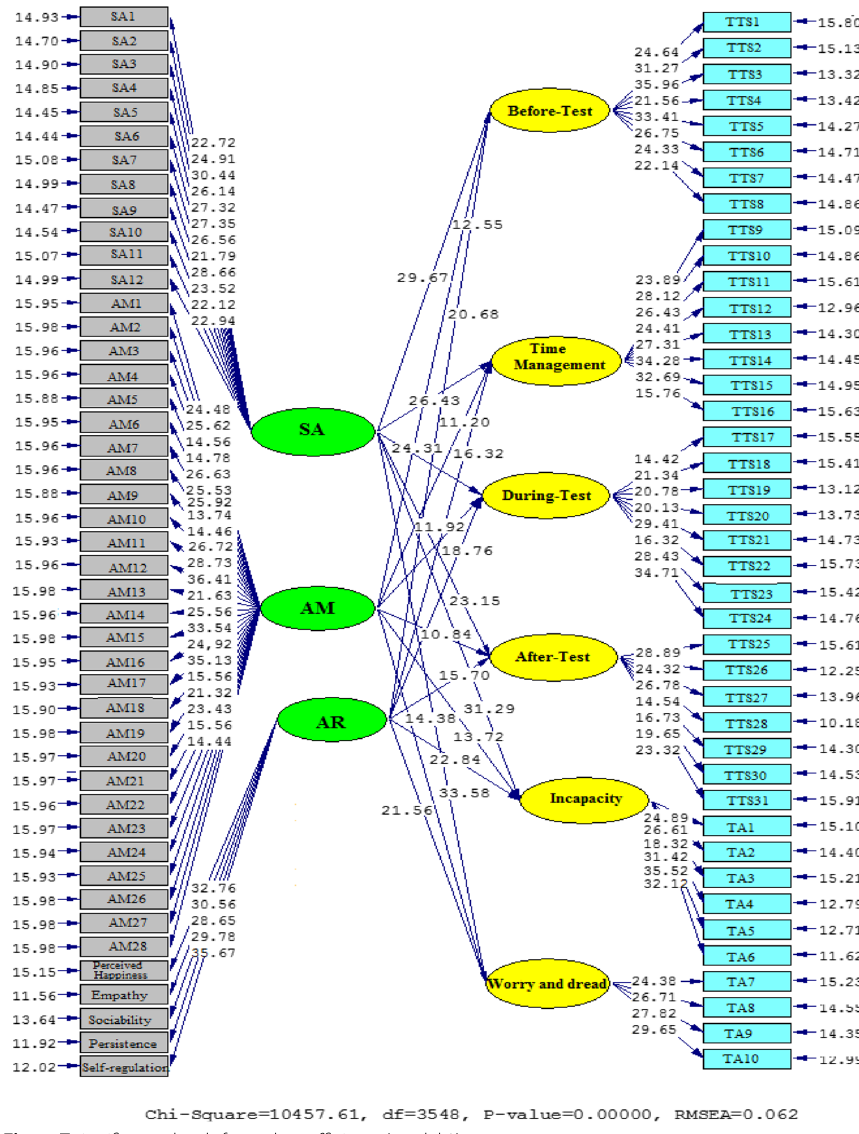
Fig. 5 T significance levels for path coefficients (model